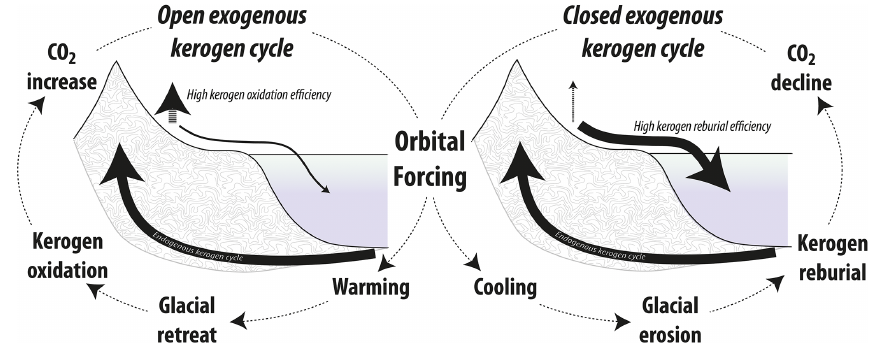
Figure 2. Conceptual hypothesis overview: changes in kerogen reburial efficiency and its effect on the reentry of ancient carbon into surficial carbon pools as a function of overall climate state. During glacial times, kerogen reburial is promoted by the activity of glaciers and ice sheets, with relatively little oxidation of this carbon during its transit across Earth’s surface characteristic of a “closed” exogenous kerogen cycle. During glacial terminations and interglacials, the oxidation of kerogen is more efficient, leading to the exhalation of this carbon to the atmosphere characteristic of an “open” exogenous kerogen cycle. Table 1. Carbon budget example illustrating a possible partitioning of carbon between pools mirroring the characteristic features of the stable carbon isotope trajectory of marine DIC and atmospheric CO 2 from the Last Glacial Maximum into the Holocene working with the idea of kerogen oxidation (see also Fig. 3). Last Glacial Maximum Transition (ca. 12–15kyrBP)